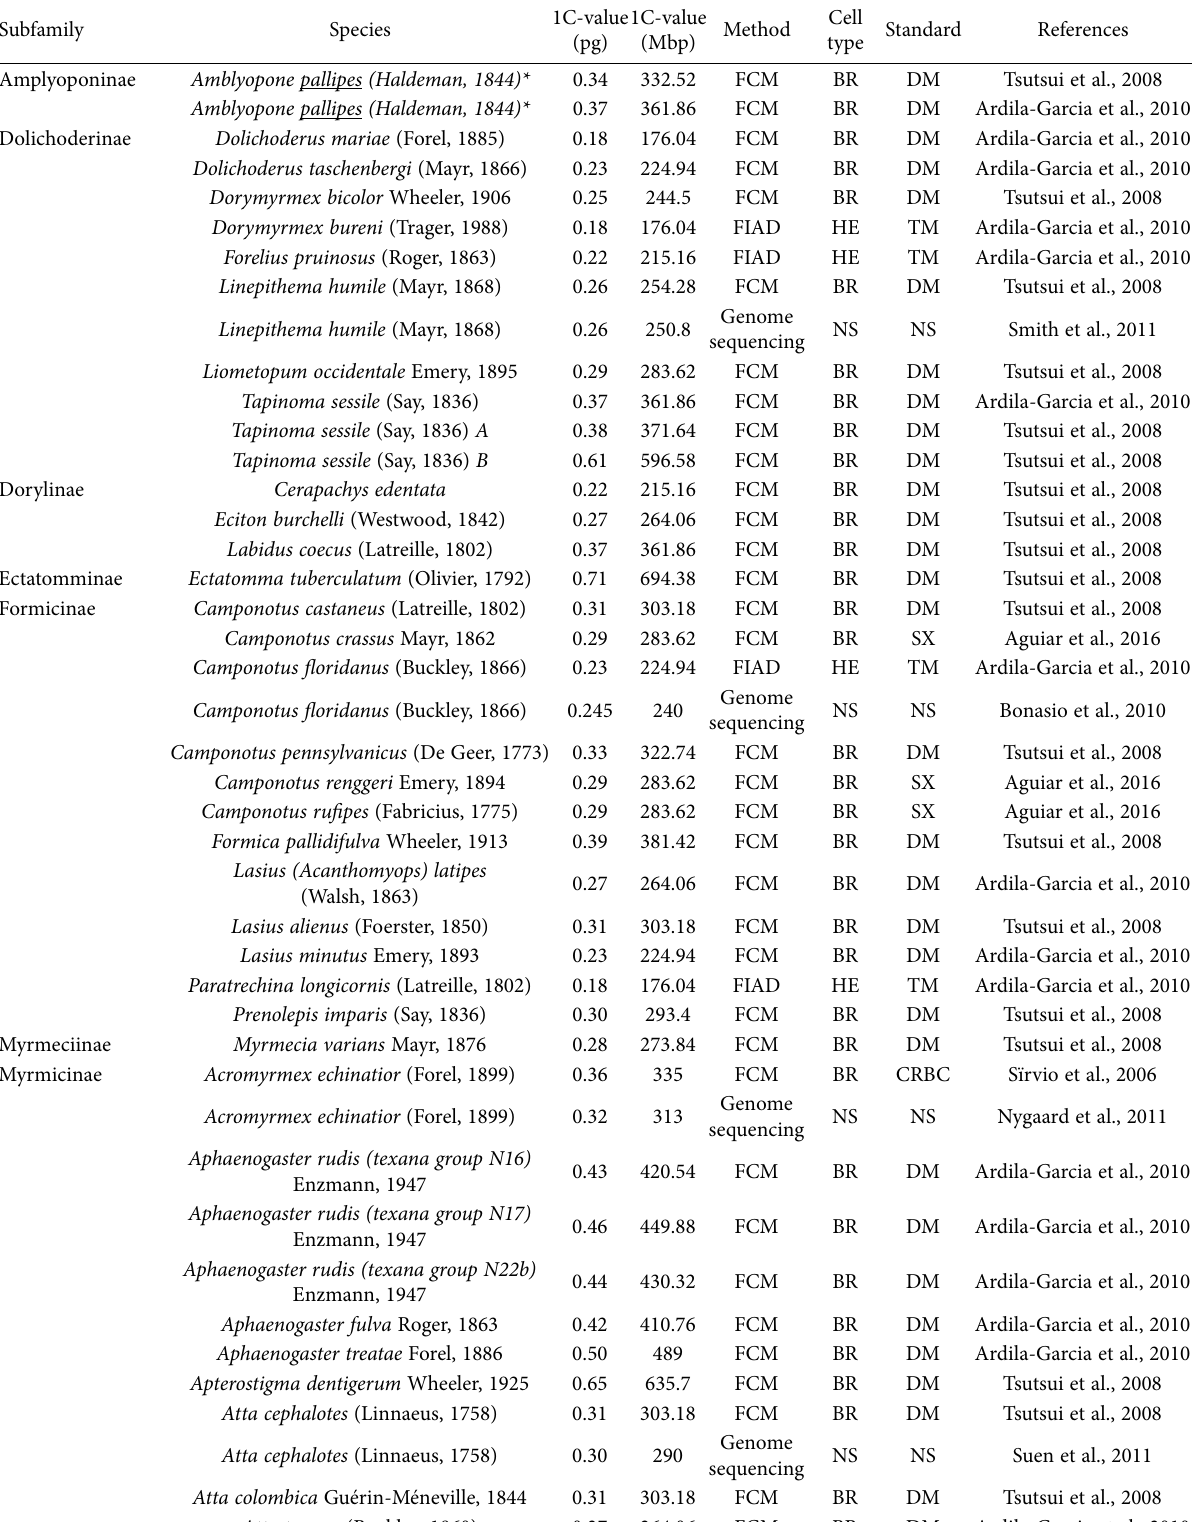
Table 1. Overview of the genome size data available in literature for Formicidae species.